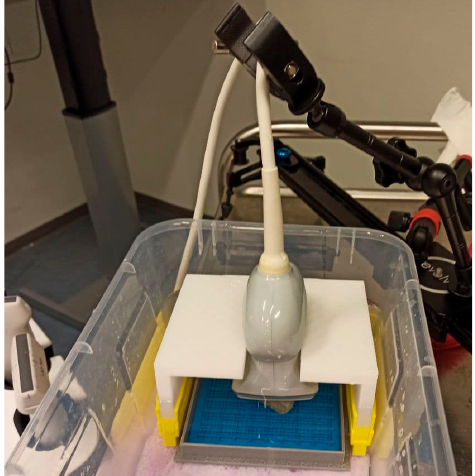
Figure 1. Three-dimensional ultrasound imaging of the specimen. A holder is used to keep the probe at the desired position. The height of the probe front-face in relation to the specimen surface is adjusted using the yellow elongators.